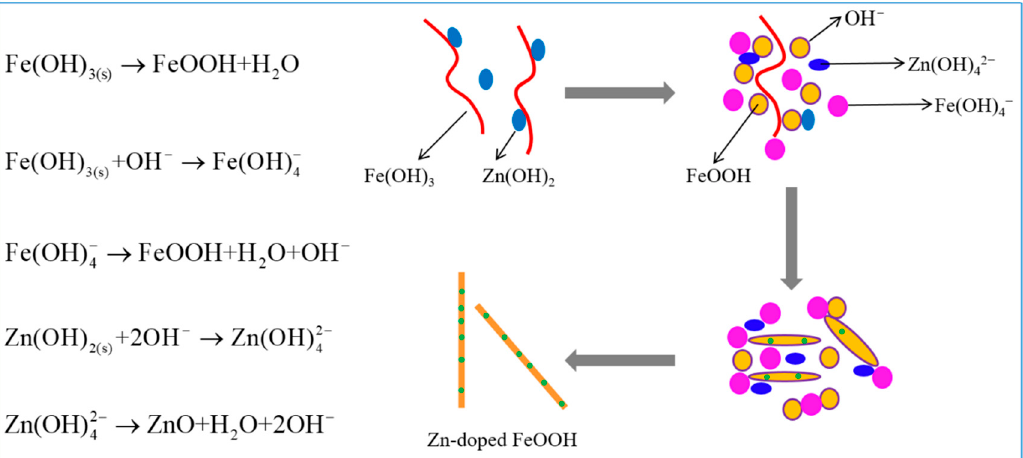
Figure 7. Schematic diagram of the formation process of Zn-doped α -Fe 2 O 3 nanowires.